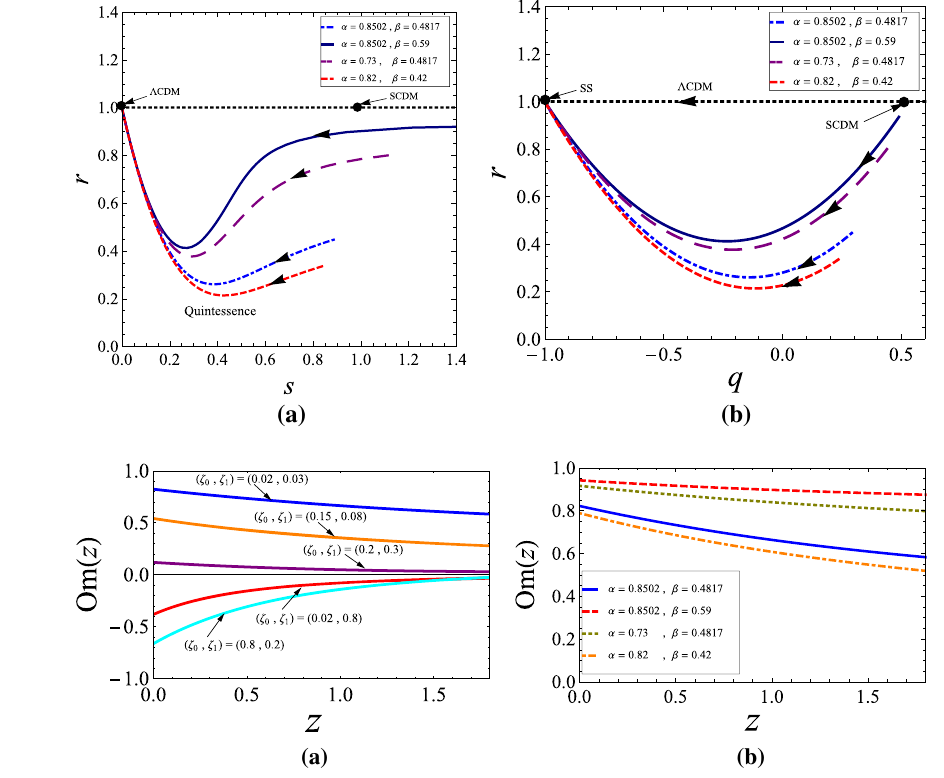
Fig. 10 a The evolution of Om(z) versus the redshift z for different values of ζ 0 > 0 and ζ > 0 with ω = − 0 . 5, d 1 α = 0 . 8502 and β = 0 . 4817. b The evolution of Om(z) versus the redshift z for different values of α and β with ζ 0 = 0 . 02, ζ = 0 . 03 and ω = − 0 . d 1